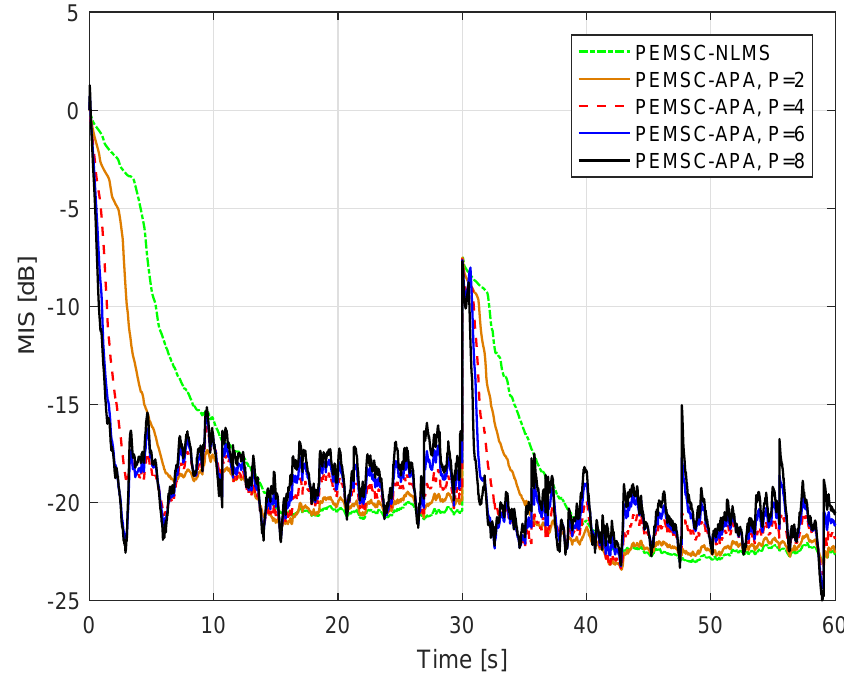
Figure 6. Normalised misalignment of the PEMSC-NLMS, PEMSC-APA with P ∈ [ 2,4,6,8 ] , speech input, feedback path changes from F 1 to F 2